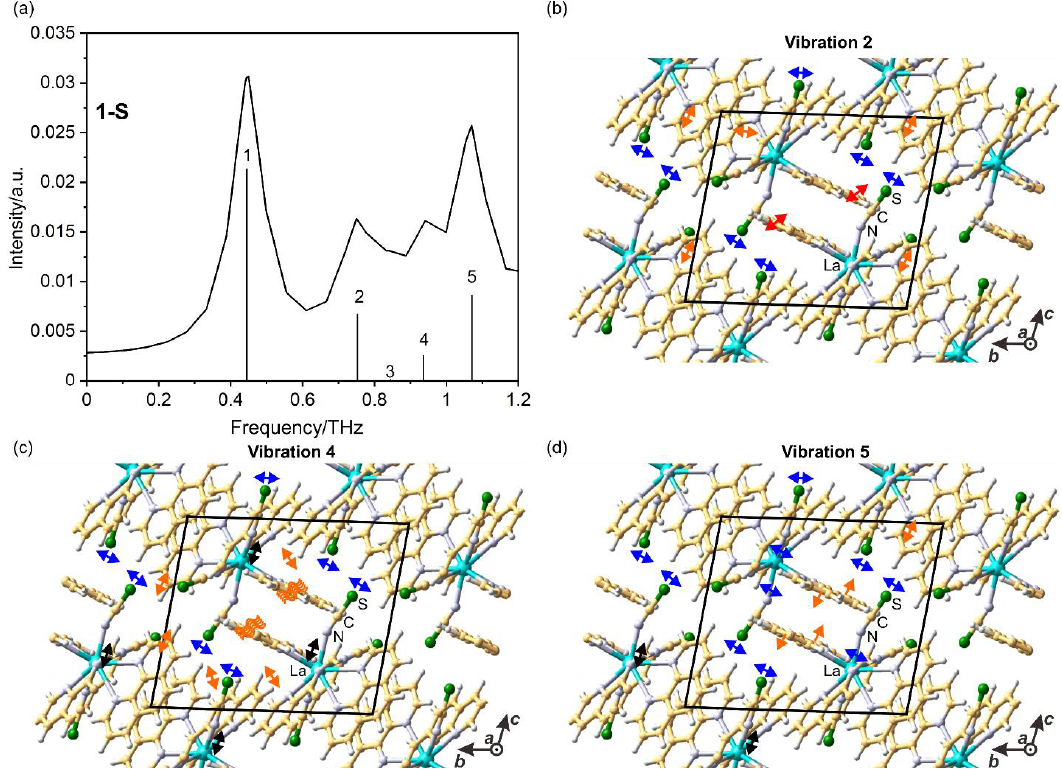
Figure 2. ( a ) Calculated vibrational IR active modes, and ( b – d ) graphic representations of the lowest energy phonon modes: 2, 4, and 5, for 1-S . The blue, black, and orange arrows indicate the vibration vectors. The numbers on top of the bars in ( a ) correspond to the vibrations in ( b – d ), and the height of these bars represents their calculated relative intensity. Graphical representations of vibrations 1